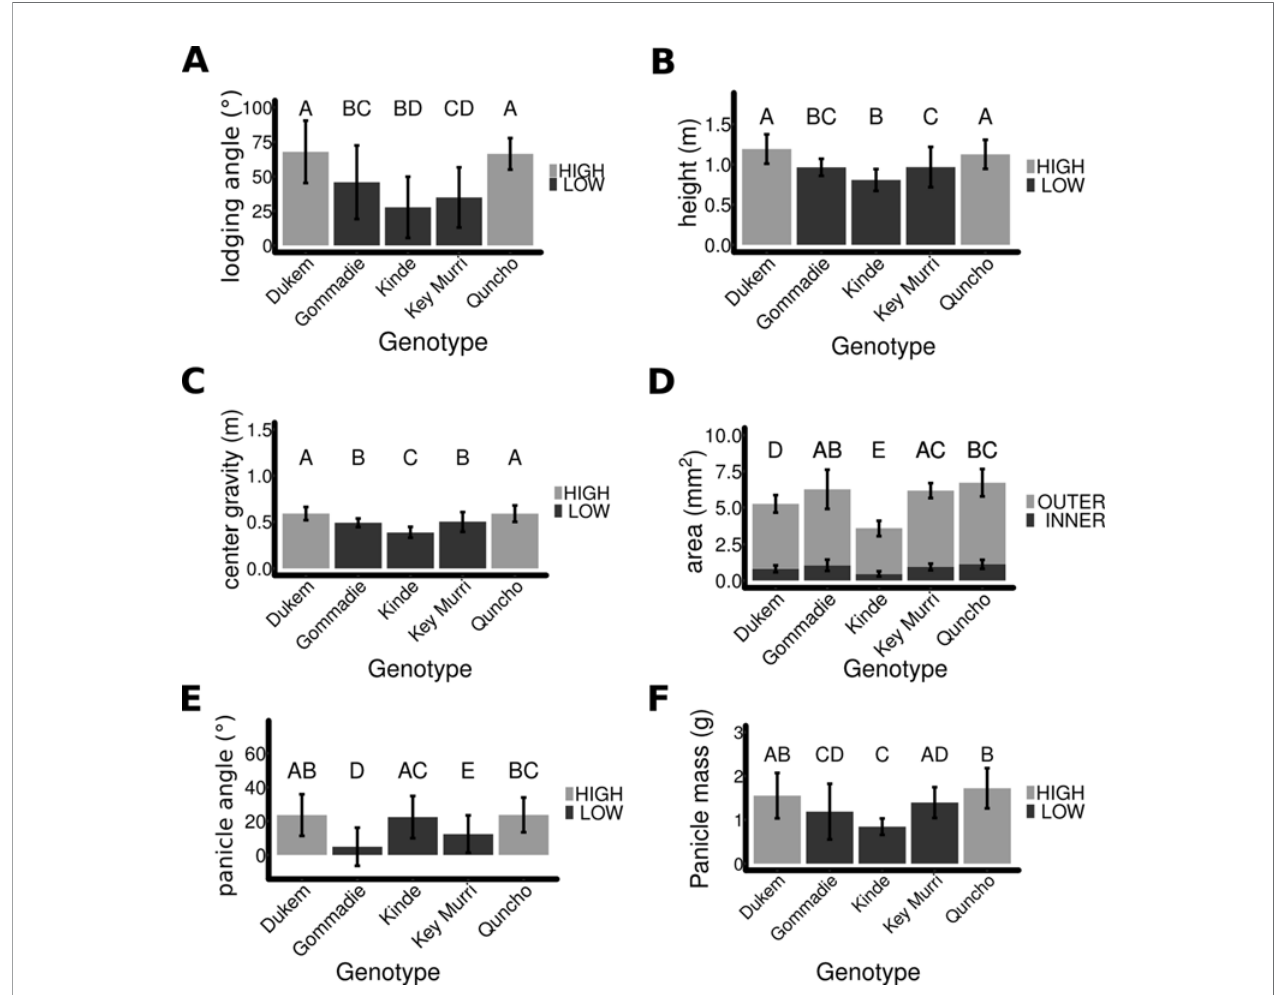
FIGURE 2 | A comparison of morphological traits in different tef genotypes. (A) Lodging angle in the different Tef genotypes. (B) Plant height of the fi ve genotypes. (C) The center of gravity of each ecotype determined by measuring the mass and length of each internode. (D) The cross-section of the fi rst internode of each genotype. The area of the hollow inside (dark) was subtracted from the outer area (light). (E) The angle between the tip of the panicle and stem. (F) The mass of the panicle. Bars show mean error for standard deviation. The same letter denotes sample means that are not signi fi cantly different from each other (p > = 0.05) as determined by Tukey